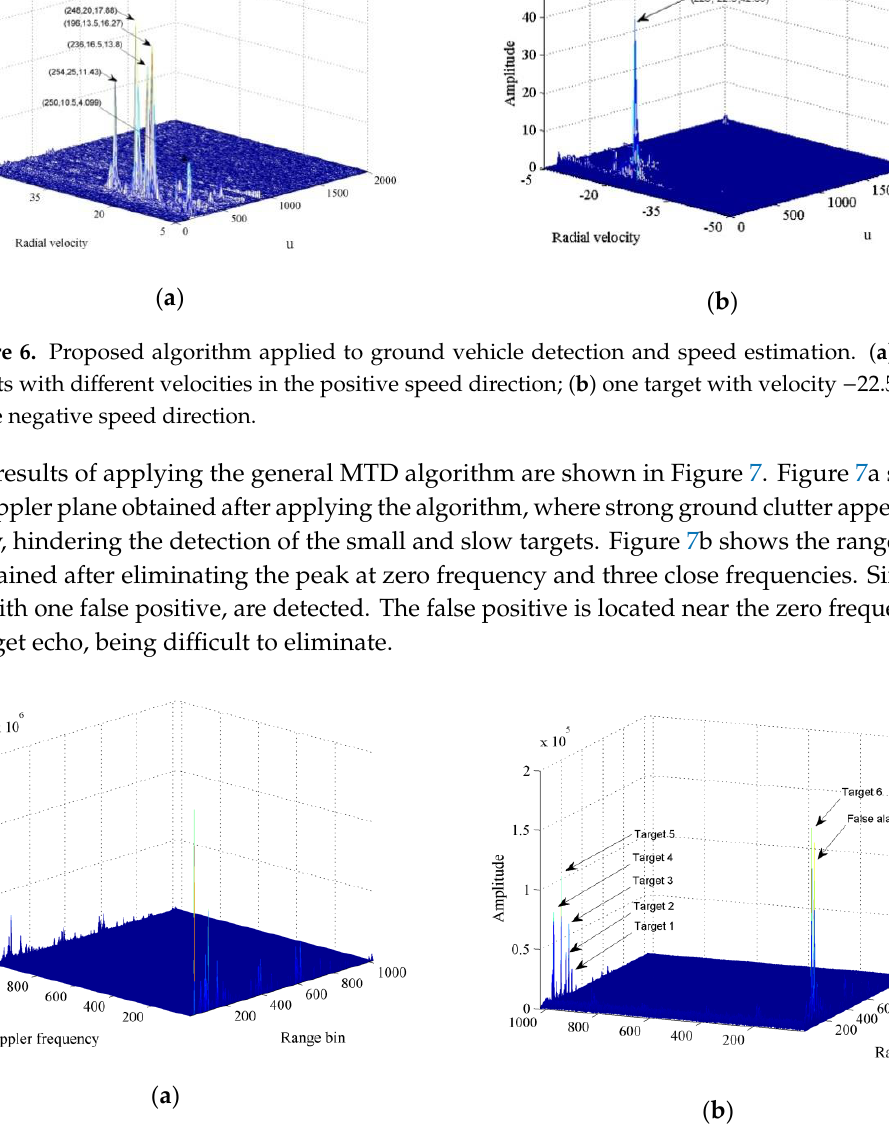
Figure 5. Fractional Fourier transform (FRFT) results of measured echoes with pulse repetition T  and sampling frequency 10 MHz interval 200 μs pri 1024 continuous echoes.